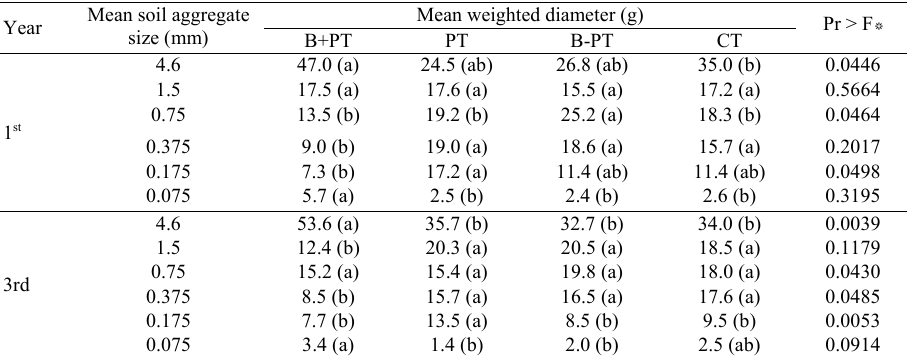
Table 2: Comparing change in soil aggregate size distribution between treatments in the first and third years